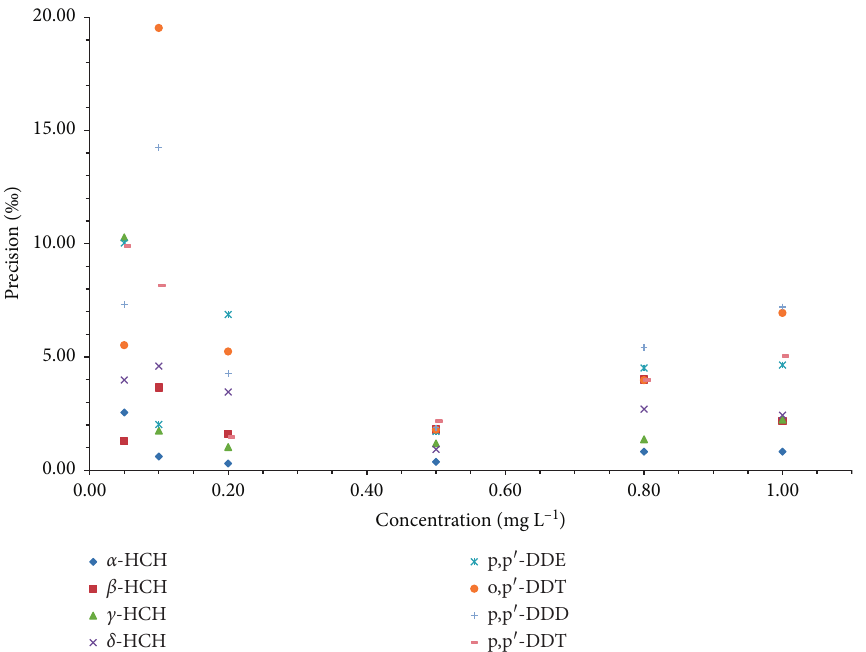
Figure 6: Precisions of IR ( 37 Cl/ 35 Cl) values at different concentrations for eight organochlorine pesticides: α -hexachlorocyclohexane ( α -HCH), β -hexachlorocyclohexane ( β -HCH), c -hexachlorocyclohexane ( c -HCH), δ -hexachlorocyclohexane ( δ -HCH), 1-chloro-2-[2, 2, 2- trichloro-1-(4-chlorophenyl) ethyl] benzol (o, p ′ -DDT), 2, 2-bis ( p -chlorophenyl)-1, 1, 1-trichloroethane ( p , p ′ -DDT), 2, 2-dichloro-1, 1-bis (4-chlorophenyl) ethylene ( p , p ′ -DDE), and 1, 1-dichloro-2, 2-bis ( p -chlorophenyl) ethane ( p , p ′ -DDD).